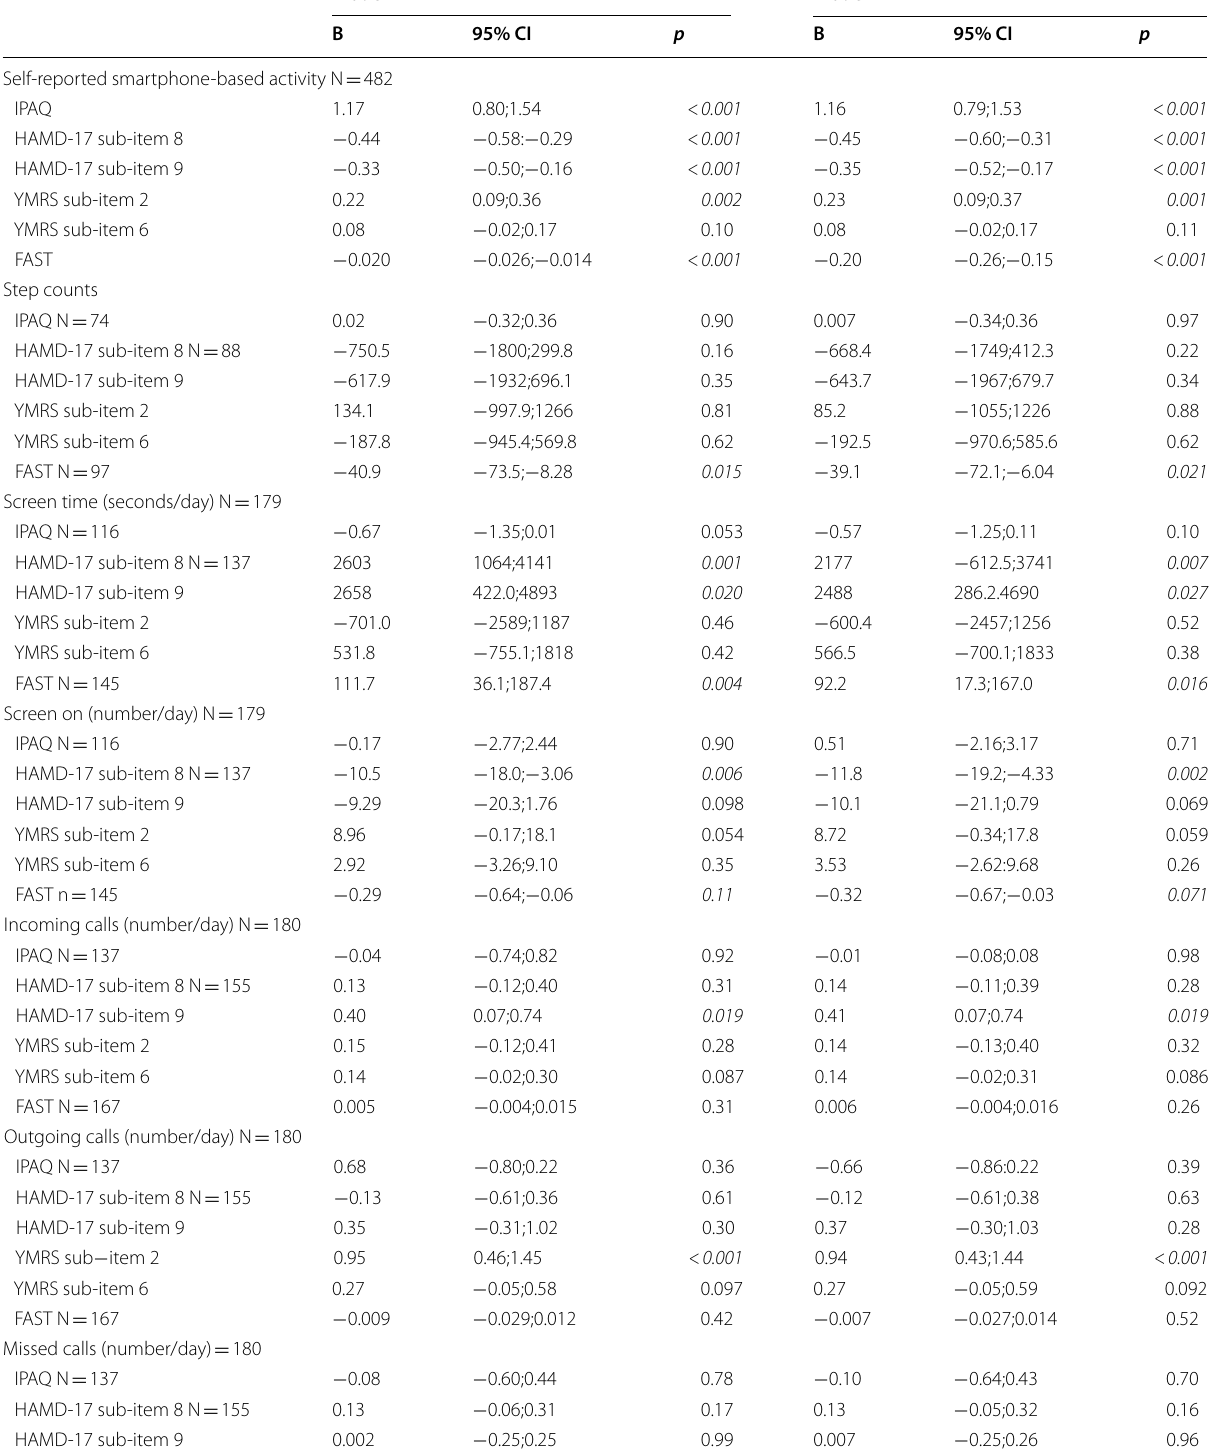
Table 2 Associations between smartphone-based activity measurements a and self-reported physical activity and observer-based rating scales for depression, mania and functioning (data pooled for patients with bipolar disorder, unaffected relatives and healthy control